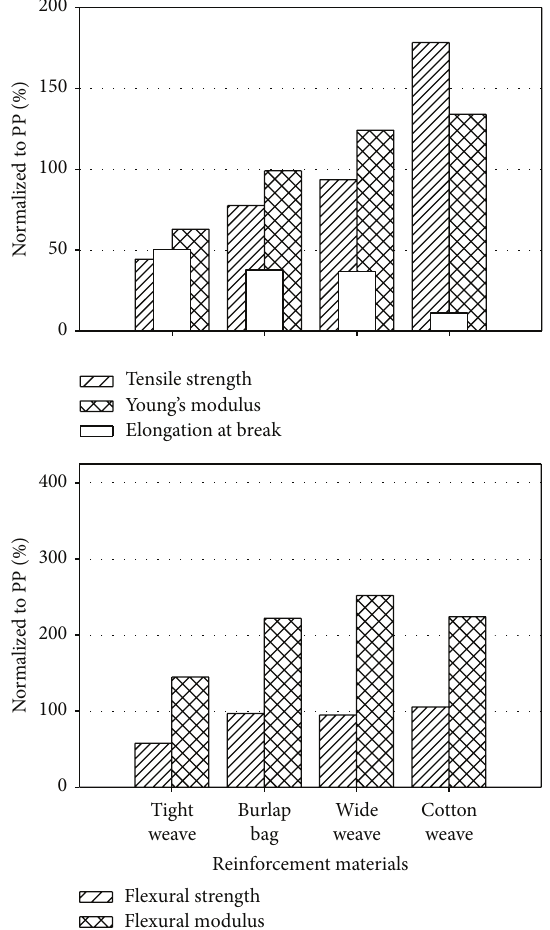
Figure 5: Normalized effect of reinforcement materials on the mechanical properties of LCs compared to HDPE.